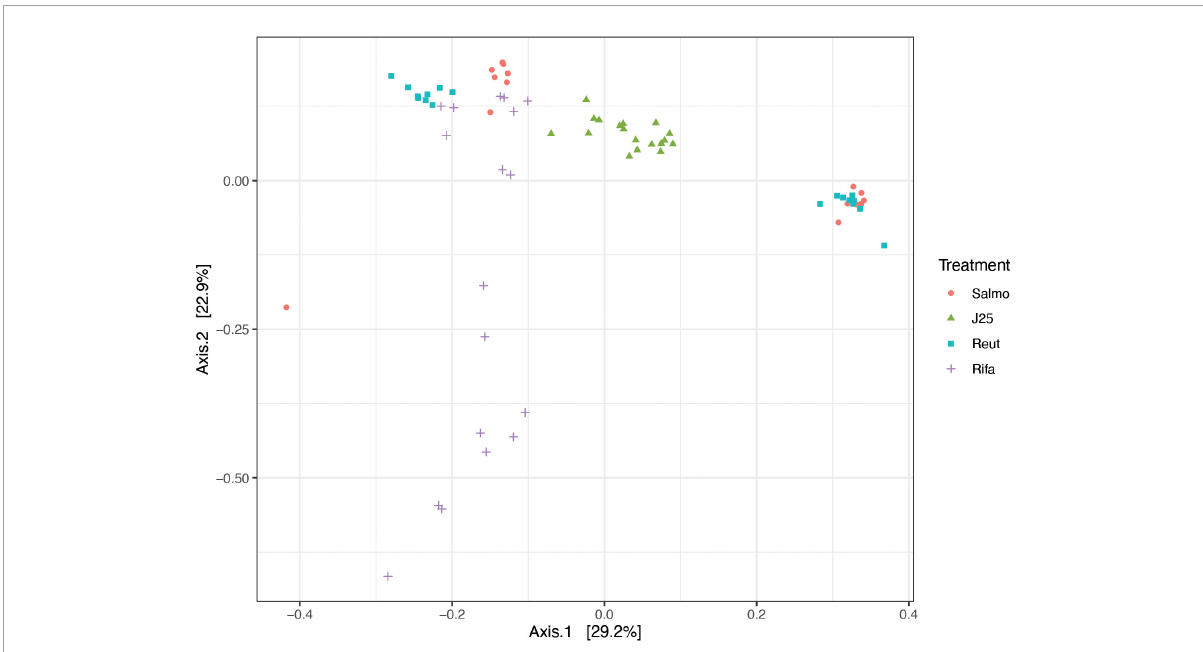
FIGURE2 Principal coordinate analysis (PCoA) of porcine microbiota after inoculation of Salmonella Newport alone (Salmo) and in combination with MccJ25 (J25), reuterin (Reut) or rifampicin (Rifa) in vitro, based on Bray-Curtis similarity matrix from all time points from the two independent experiments. Dots are colored by